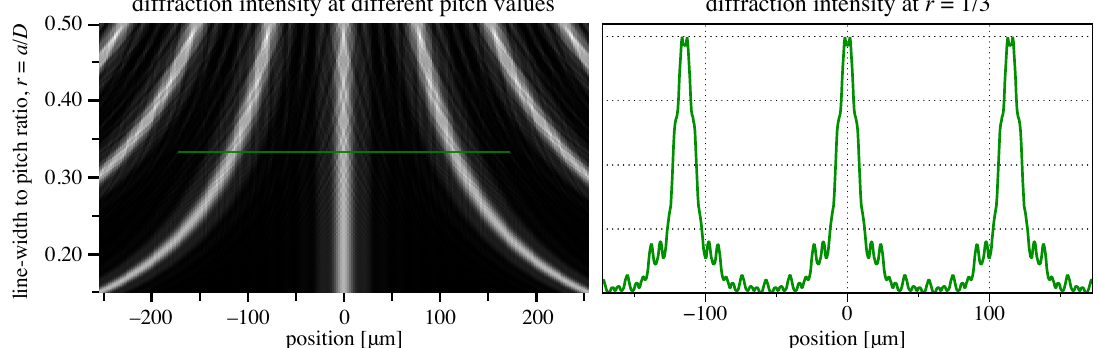
Figure 3. Coherent wave-propagation calculations of Hartmann grid diffraction intensity patterns as a function of the pitch, D . A constant line width, a = 38.203µm, is maintained (Equation (8)). The plot on the right shows three periods of the pattern, calculated at r = 1/3, extracted at the position of the green